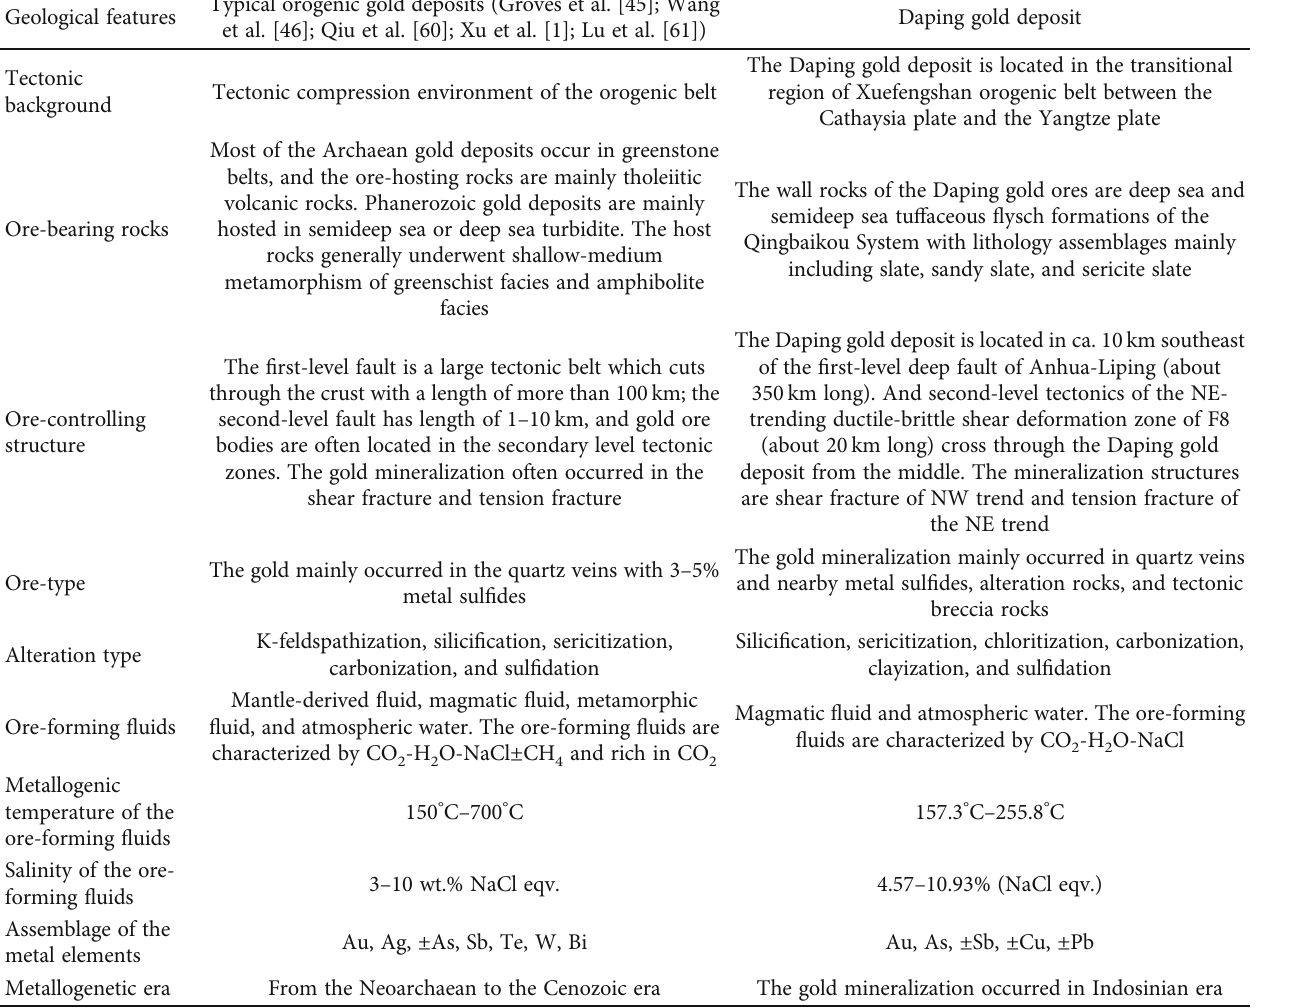
Table 9: The comparison of geological features between the Daping gold deposit and typical orogenic gold deposits. Geological